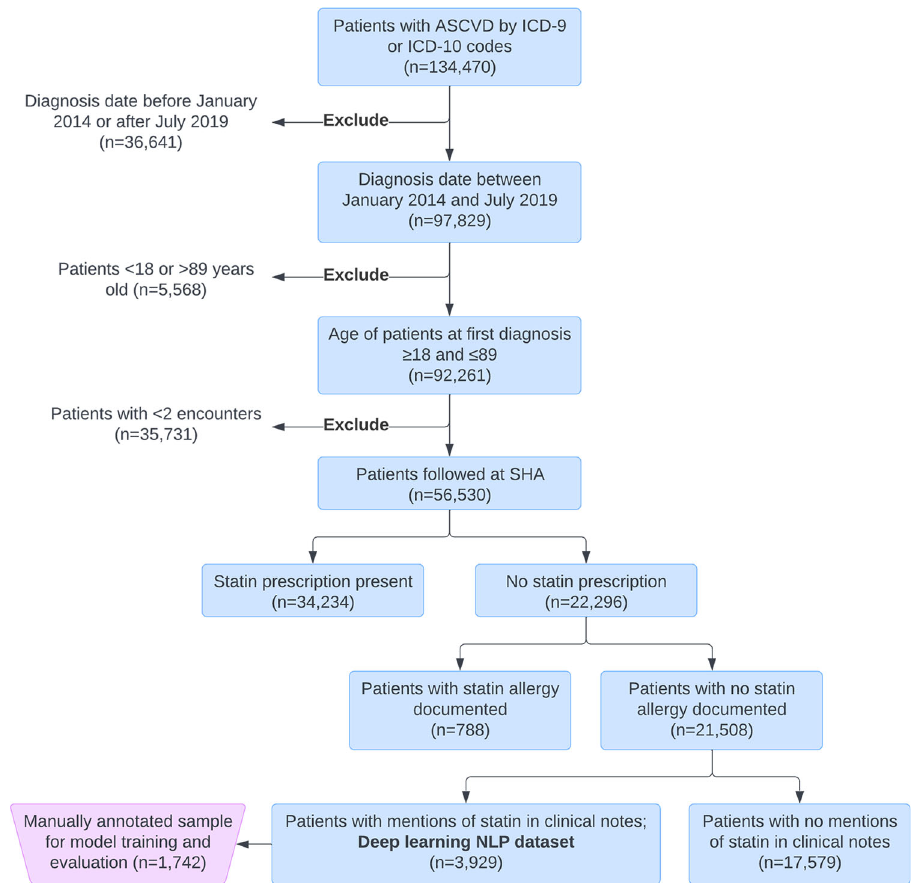
Fig. 1 CONSORT-style diagram for cohort selection. Abbreviations: ASCVD atherosclerotic cardiovascular disease, SHA Stanford Health Care Alliance (consisting of an academic hospital, a community hospital, and a community practice clinic network), NLP natural language processing. “ Statin allergy documented ” refers to the documentation of a statin allergy in the structured “ allergies ” fi eld of the